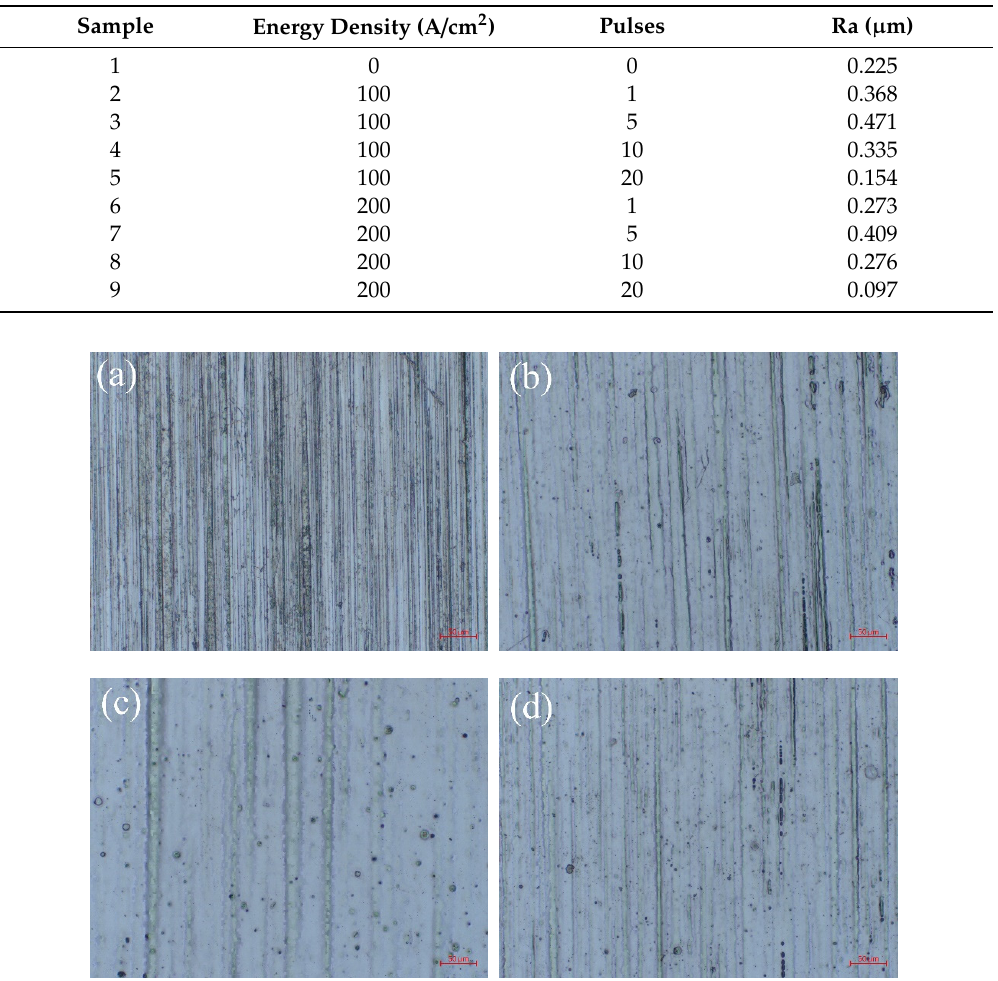
Table 3. Average surface roughness of IN718